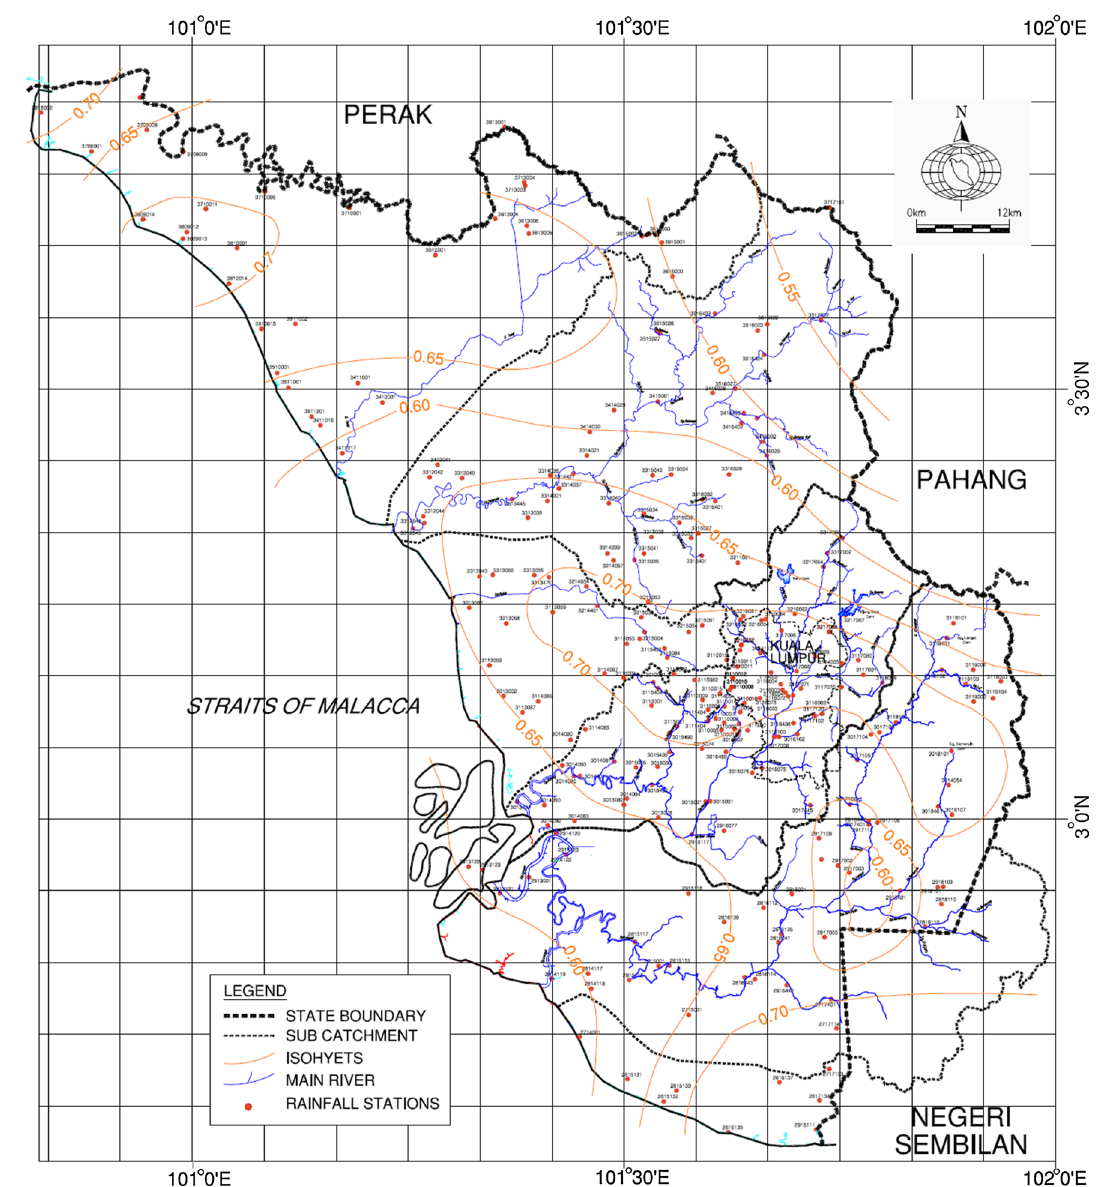
Fig. 4 Isohyetal map of the 1-hr rainfall ratio (SDRC) to the daily rainfall